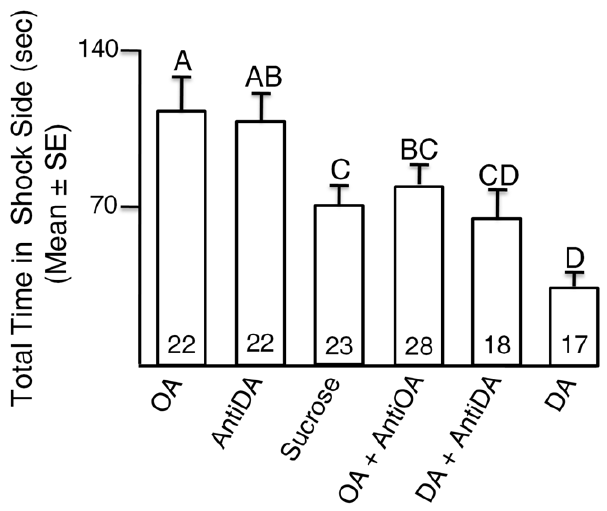
Figure 3. Avoidance conditioning learning curves. Bees in the principal treatment groups (control, OA, and DA) all showed increase in learning index over time (Repeated measures MANOVA, time 2 10 blocks-: F=13. 25; df=9; P , 0.001). OA group bees showed a significantly slower increase and reached a lower maximum learning index (Repeated measures MANOVA, groups (3): F=4.06, df=2, P , 0.025). doi:10.1371/journal.pone.0025371.g003 training, mean 6 SE for control: 0.93 6 0.04; for DA: 0.99 6 0.06; for OA: 0.78 6 0.08; ANOVA df = 43, F =2.5117; P= 0.10).